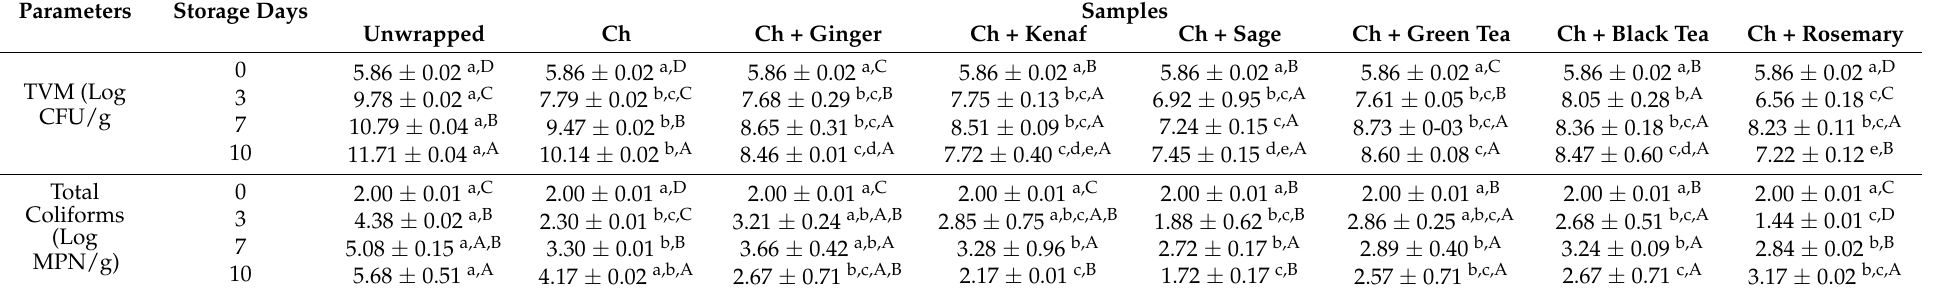
Table 2. Mean values of the microbiological analysis demonstrated by the various samples over the evaluation